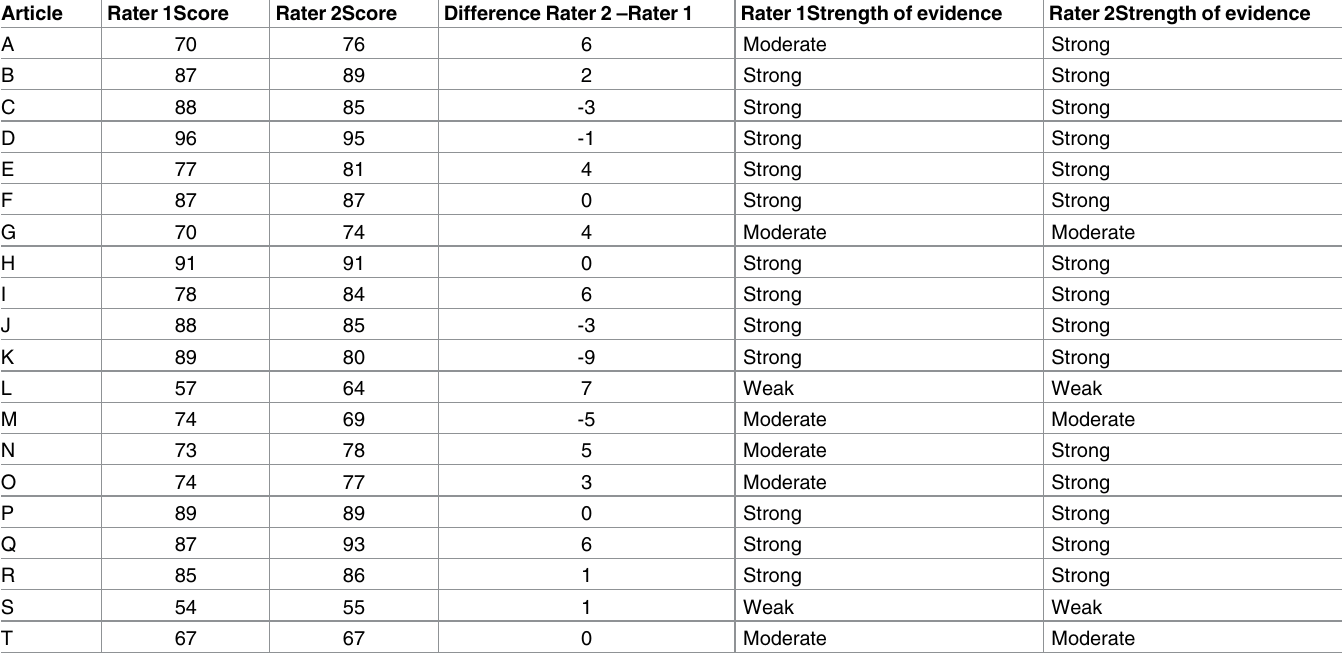
Table 3. Comparison of ResQu Index scores on selected articles by two